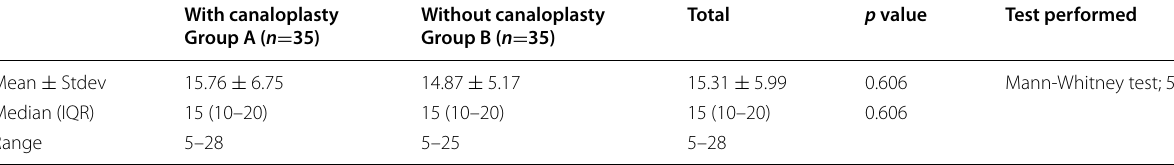
Table 3 Comparison of AB gap closure at 12 weeks between with and without canaloplasty With canaloplasty Group A ( n =